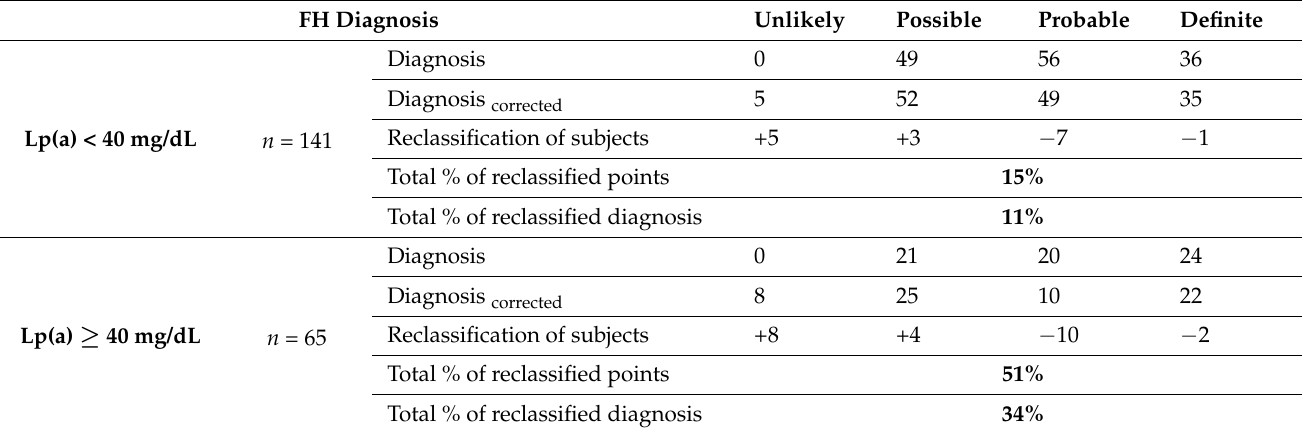
Table 2 . Effect of Lp(a) concentration ≥40 mg/dL on reclassification FH diagnosis ( n = 206).